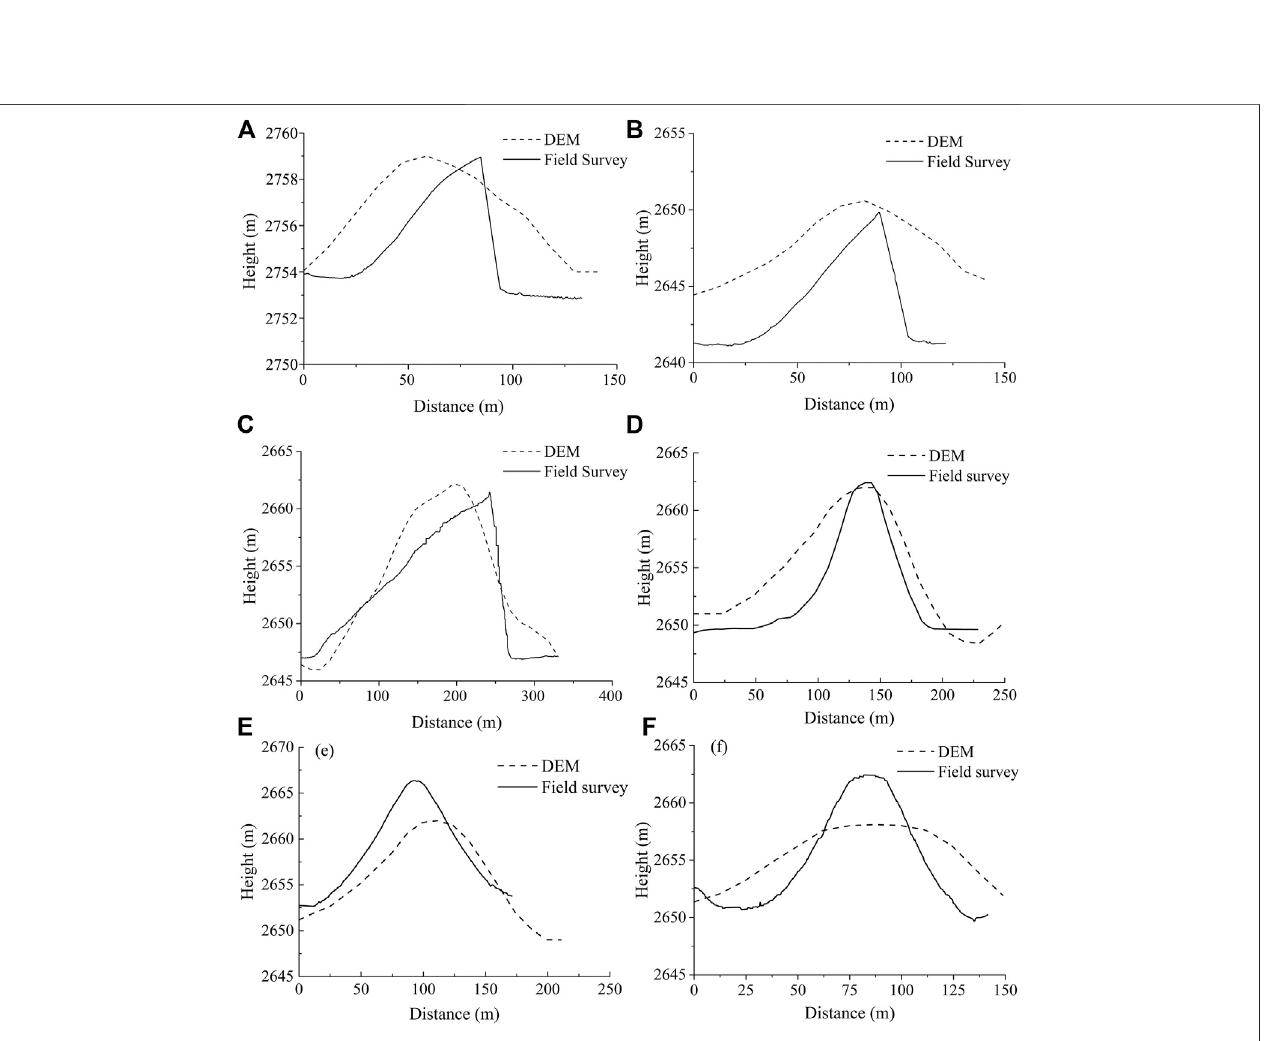
Frontiers in Earth Science |